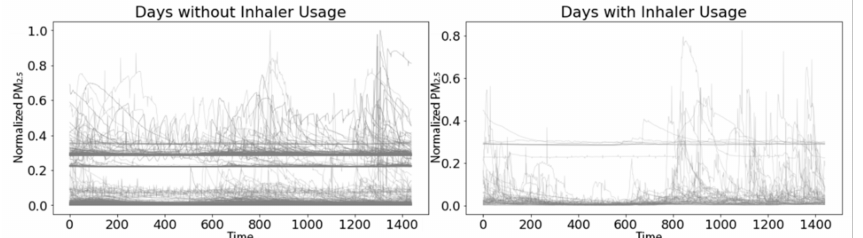
Figure 12. Daily indoor PM 2.5 time series from the 763 days without rescue medicine use ( left ) and the 60 days with rescue medicine use ( right ). Each time series is 1440 min long and the PM values have been min-max scaled to lie on the unit interval.